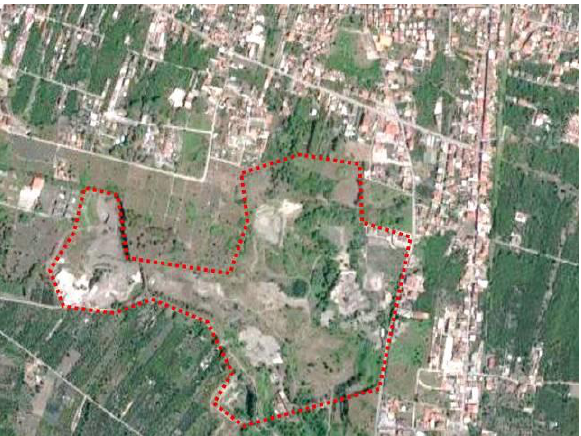
Figure 15. Ranieri quarry in Boccia al Mauro, Terzigno